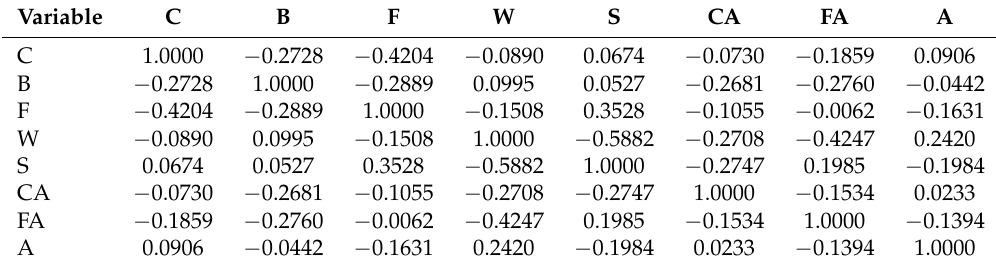
Table 2. Correlation coefficients between the input